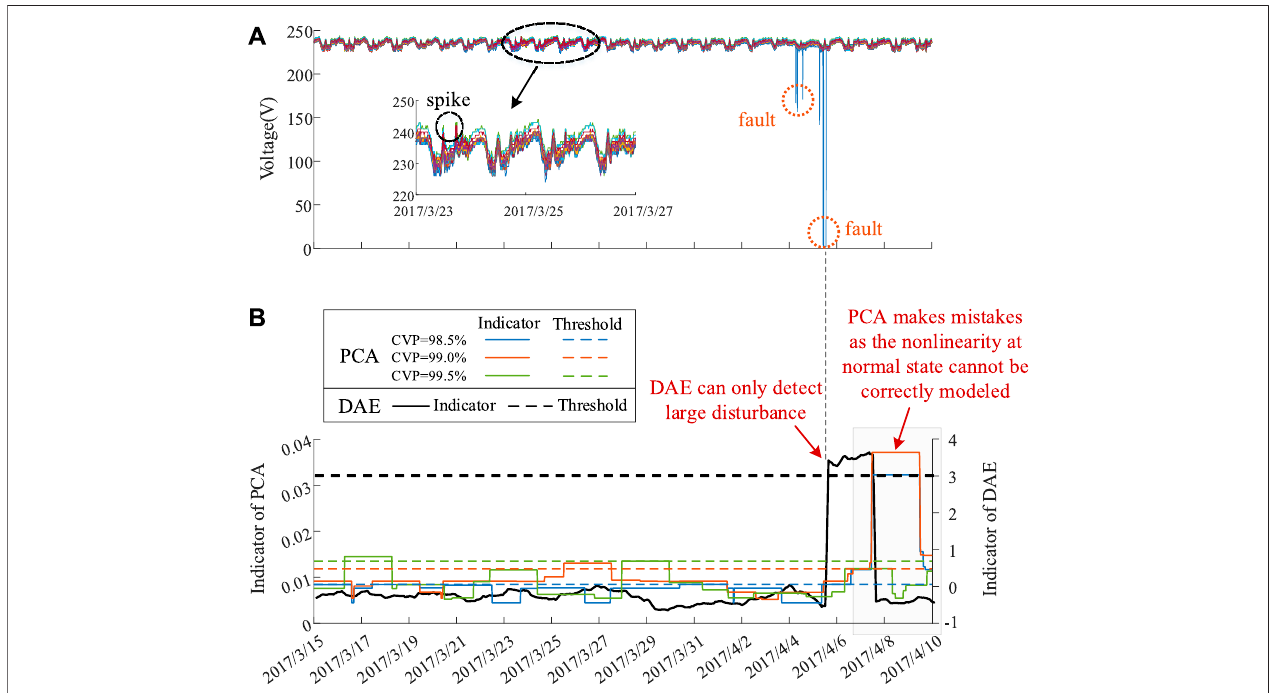
FIGURE 3 | (A) Real-world measurements of three-phase voltage magnitudes obtained at load-side transformers; (B) detection results of DAE and PCA under different CVPs.